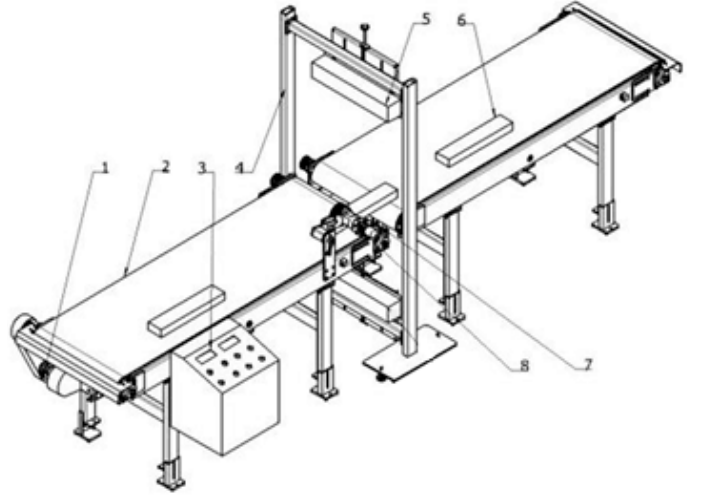
Figure 1. Image acquisition device: (1) transmission device, (2) transmission belt, (3) control panel, (4) CCD camera holder, (5) CCD camera, (6) sample solid wood floor panel, (7) photoelectric sensor, and (8) pressure wheel. Table 1. Specific parameters of the CCD